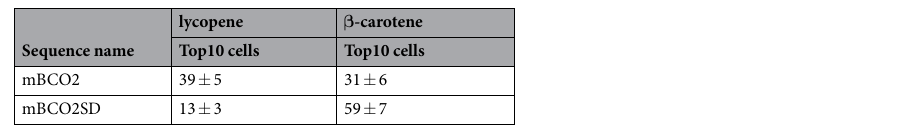
Table 4. Catalytic activity of mouse BCO2 (mBCO2) and mouse BCO2P108SN190D (mBCO2SD) proteins (% substrate left compared to uninduced